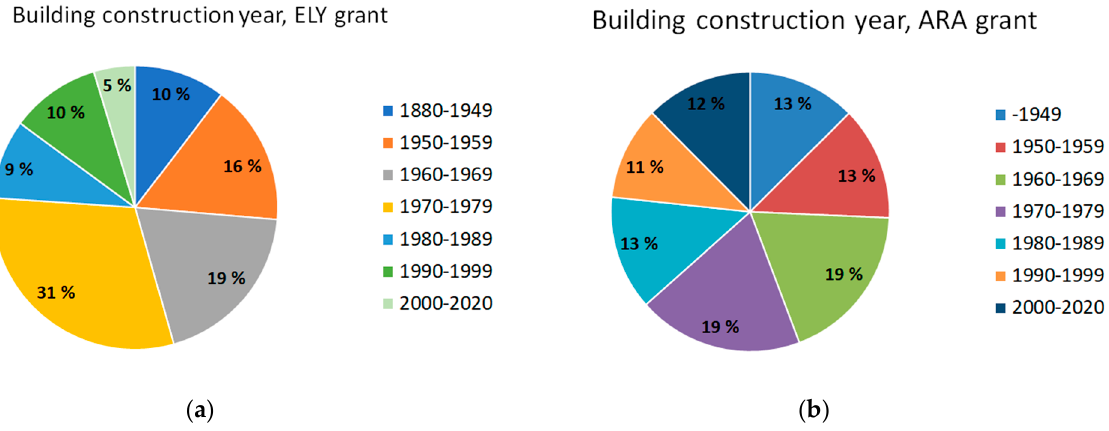
Figure 2. The grant distribution according to the building age for ( a ) ELY grant and ( b ) ARA grant.